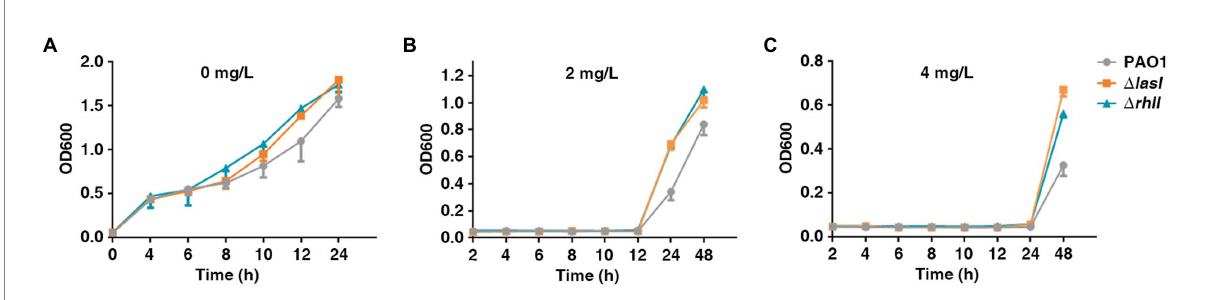
FIGURE 5 The growth rate of PAO1, PAO1 Δ lasI , and PAO1 Δ rhlI in the presence or absence of antibiotic selection. (A–C) PAO1, PAO1 Δ lasI , and PAO1 Δ rhlI were treated with 0, 2 or 4 mg/l of